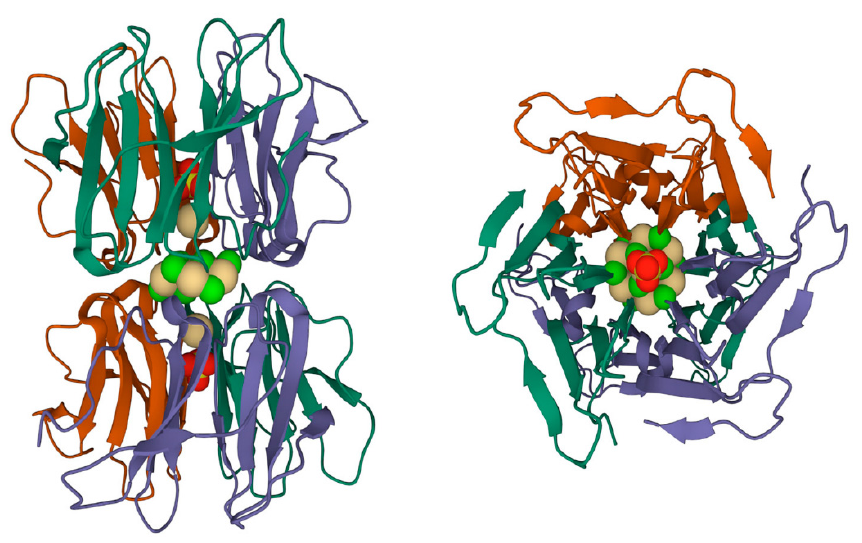
Figure 6. Designed protein for the synthesis of nanocrystals. Two orthogonal views of the designed protein nvPizza2-S16H58 (PDB entry 5chb) [60]. The protein sandwiches a small nanocrystal, a pre-